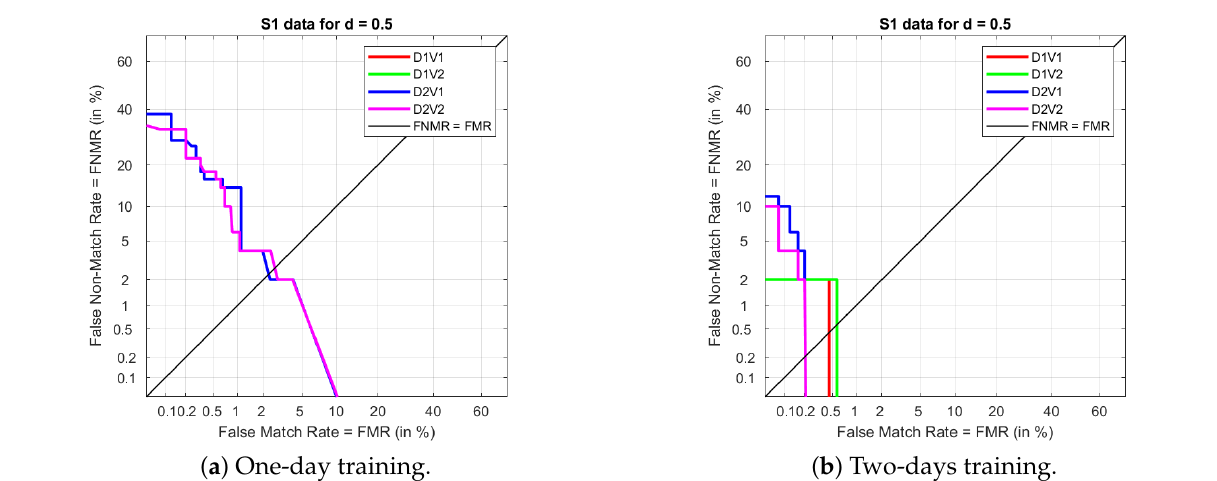
Figure 7. Performance results using data from S1 and S2.